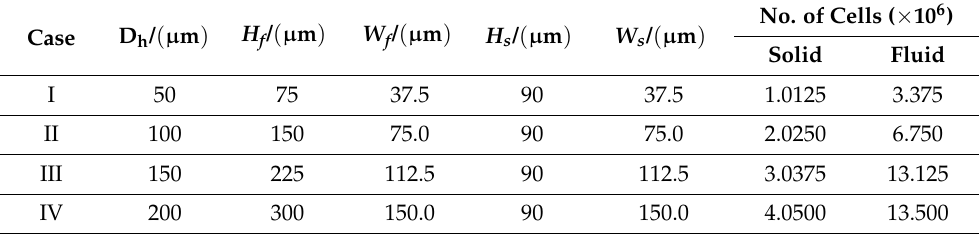
Table 1. Dimensions of the considered microchannels and total number of cells for the solid (s) and fluid (f)